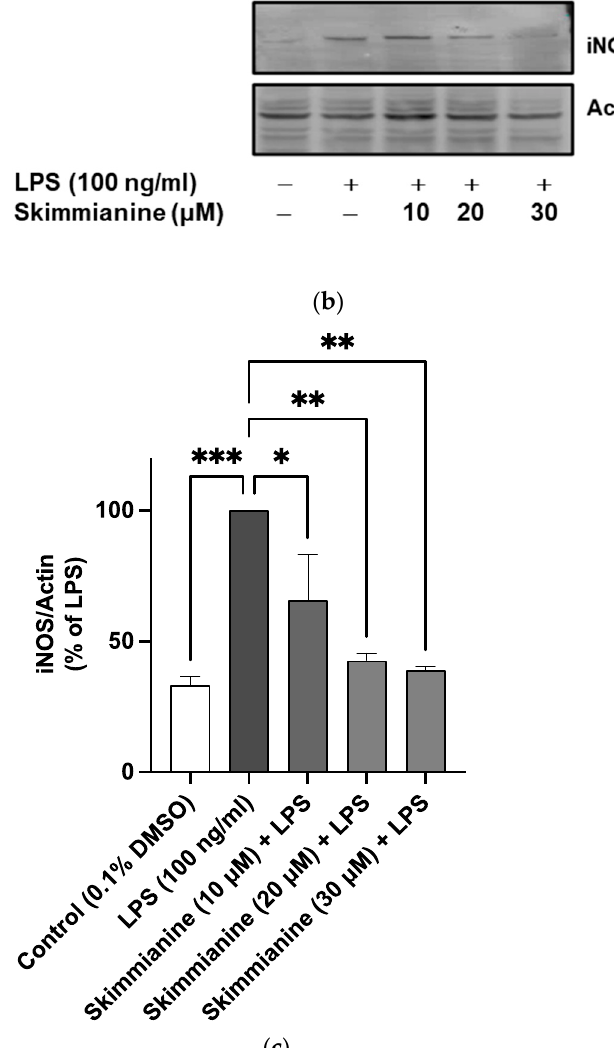
Figure 4. Skimmianine suppressed nitric oxide (NO) release ( a ) and inducible nitric oxide (iNOS) protein expression ( b , c ) in LPS-stimulated BV-2 cells. Cells were pre-treated with skimmianine (10, 20 and 30 μ M) 30 min prior to stimulation with LPS (100 ng/mL) for 24 h. Cell culture supernatants were analysed for nitrite using the Griess assay, while western blotting was used to analyse iNOS protein expression in cell lysates. Values are mean ± SEM of at least three independent experiments.